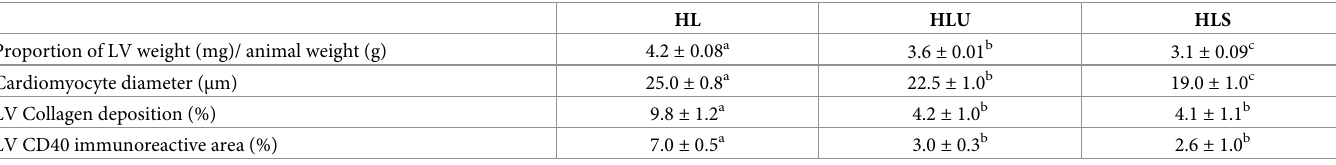
Table 2. Comparison of left ventricular weight (mg) by animal weight (g), cardiomyocyte diameter ( μ m), percentage of collagen composition in the LV immunore- active area (%) and CD40L in the LV (%) in LDLr mice -/- fed a high fat diet; PA group: Received high fat diet; HLU Group: Received high fat food and grape juice; HLS Group: Received high fat food and simvastatin.